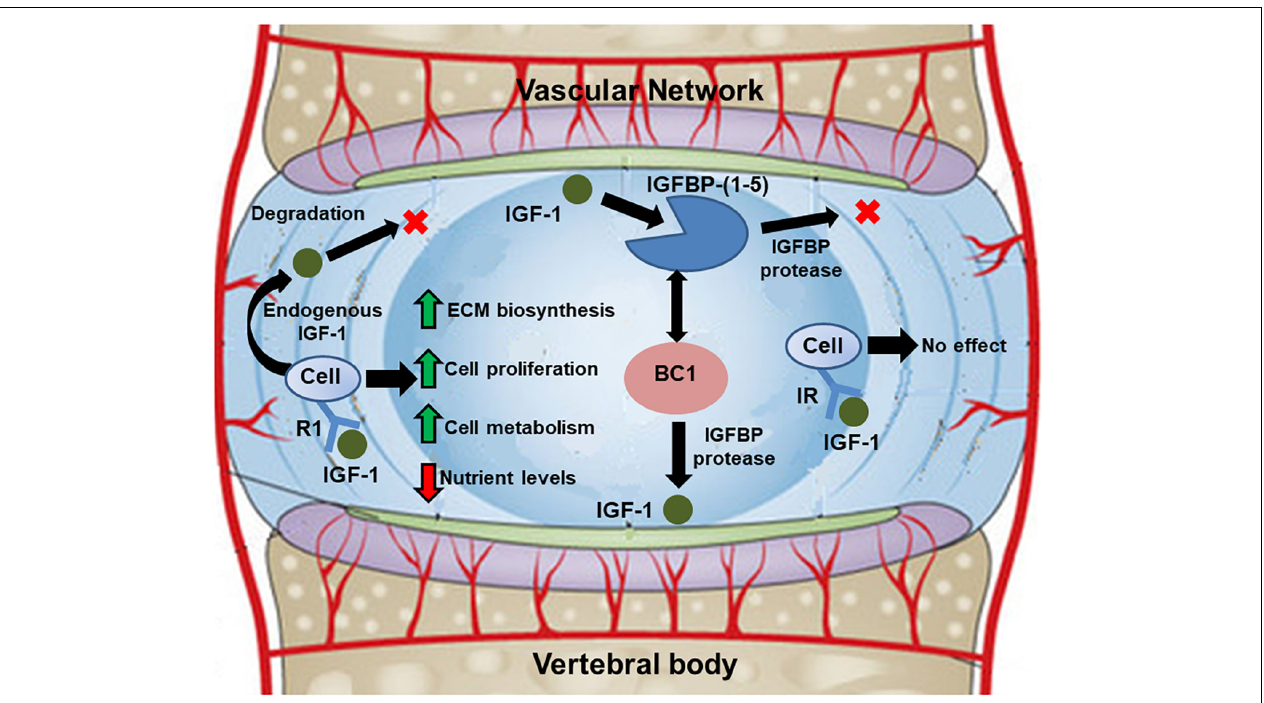
FIGURE 2 | Schematic showing diffusive-reactive transport of IGF-1 in the disc, and its implications on cell metabolism and biosynthetic activity. Adapted from Elmasry et al.